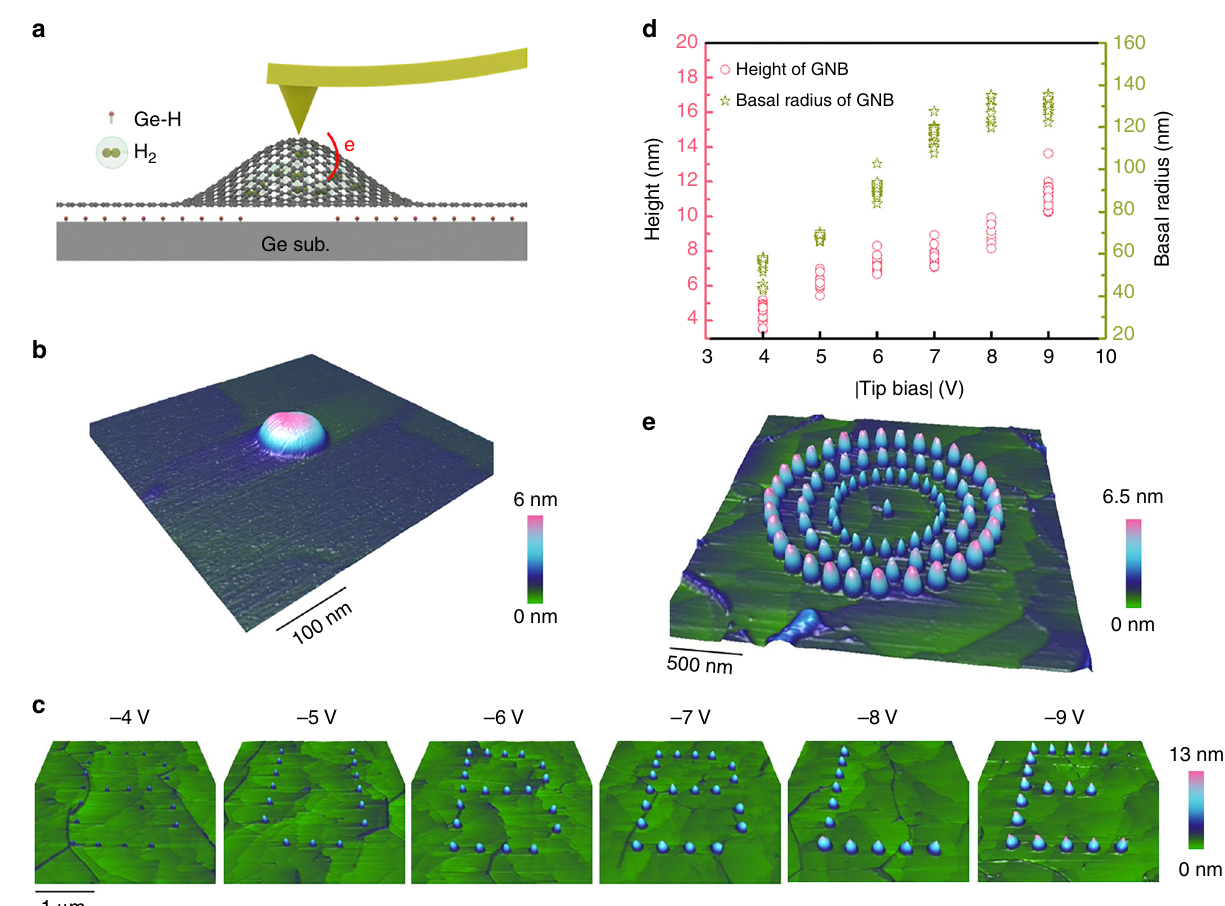
Fig. 1 GNBs induced by AFM tip. a Schematic illustration of GNBs induced by AFM tip. b A GNB induced by AFM tip with the tip voltage of − 5 V. c BUBBLE pattern of GNBs created by AFM tip with the voltage from − 4 to − 9 V scanning at the contact mode. d Height and basal radius extracted from AFM 3D images in c as a function of the tip bias. Source data are provided as a Source Data fi le. e Corral pattern of GNBs created by AFM tip working at the ramp mode. The tip voltages applied to create GNBs located at inner, middle, and outer loops are − 6 V, − 7 V, and − 8 V, respectively